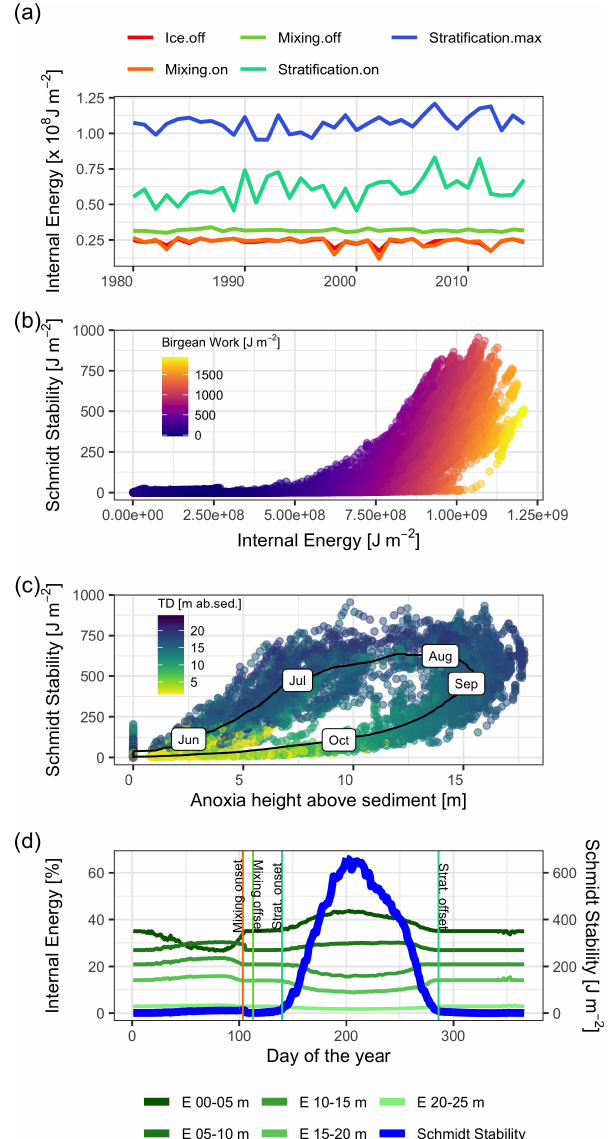
Figure 8. Stored heat dynamics and relationships to stratifica- tion strength, thermocline depth, and anoxia height (hypsographic height of anoxia area in the lake above sediment). (a) Time series of internal energy at the respective dates of ice off, mixing onset, mixing offset, stratification onset, and stratification offset. (b) Scat- ter plot of internal energy against the Schmidt stability. The color represents the magnitude of the Birgean work. (c) Scatter plot of anoxia height against the Schmidt stability. The black line repre- sents the average dynamic over the course of a year with the re- spective months as labels. The color corresponds to the thermocline depth in meters above the sediment. (d) Time series of daily aver- aged internal energies stored over different depths and the Schmidt stability. The main heat storage happens in a shallow surface layer effectively after ice off and the simultaneous onset of a mixing pe-